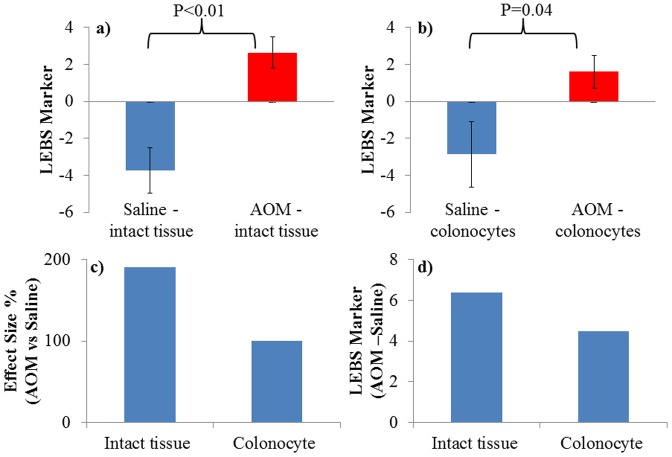
Structural Changes from intact colon tissue are partially from colon cells. a,b)The LEBS marker is altered in the intact AOM-treated rat tissue and in isolated colonocytes as compared to saline-treated rats, demonstrating differences in micro- and nano-architecture that can be captured with the LEBS technique. The magnitude of the alteration in the LEBS marker is higher for intact tissue compared to colonocytes. c,d) The effect size (2.c.) and delta (2.d.) between AOM-treated and saline-treated rats are higher for intact tissue than for isolated colonocytes. Because colonocytes are part of the intact tissue, this result suggests that colonocytes are partially responsible for differences in LEBS marker from intact tissue.